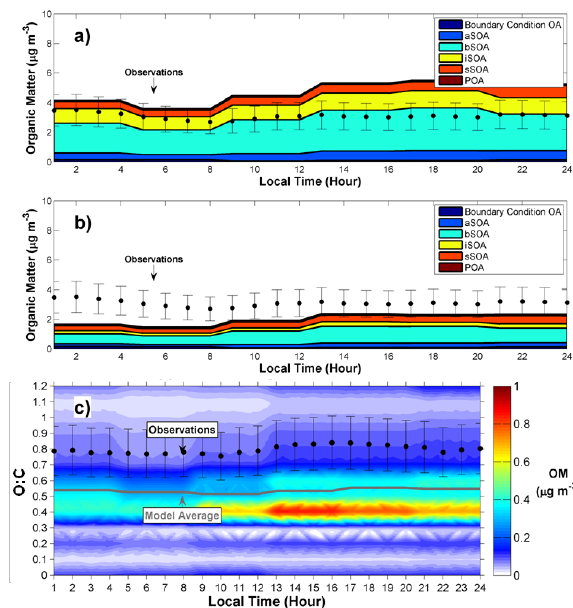
Fig. 9. Diurnally averaged (a,b) OA mass concentrations for the Figure 9. Diurnally averaged a,b) OA mass concentrations for the cases with bSOA aging with 992 cases with bSOA aging with OH reaction rate constant of 1 × 10 − 11 and 0.25 × 10 − 11 cm 3 molec − 1 s − 1 , respectively. (c) O:C for the OH reaction rate constant of 1 x 10 -11 and 0.25 x 10 -11 cm 3 molec -1 s -1 , respectively. c) O:C for 993 low OH aging rate constant the low OH aging rate constant case. 994